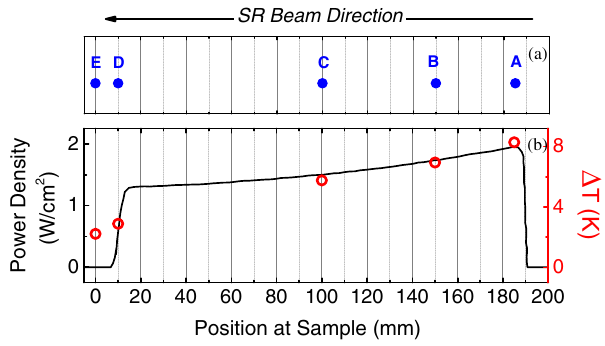
FIG. 13. (a) Schematic description of the position of each PT100. (b) Distribution of the SR power density deposited along the sample calculated by Synrad þ (black line) and temperature increments measured at different points along the sample (red dots) for a 2.5 GeV and 75 mA e − beam.